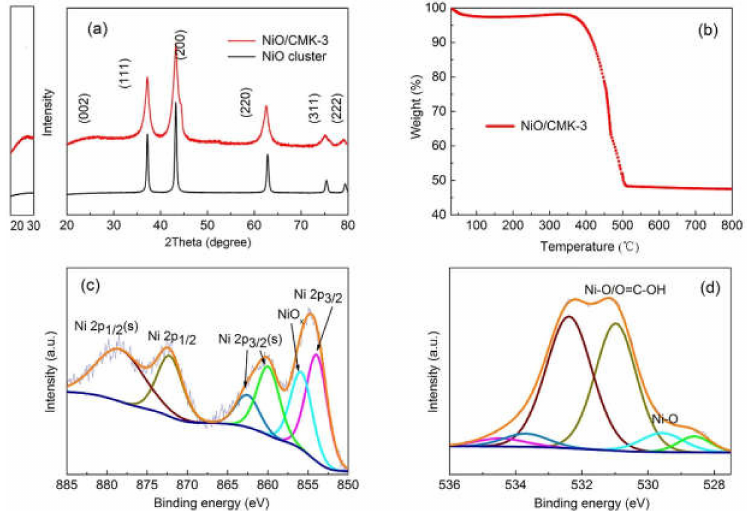
Figure 2. ( a ) XRD of the NiO / CMK-3 composite and NiO cluster; ( b ) Thermal gravimetric analysis (TGA) curve of NiO / CMK-3 composite; ( c ) Ni 2p XPS spectrum of NiO / CMK-3 composite, wine line: Ni 2 + (Ni2p 1 / 2 s), dark yellow line: Ni 2 + (Ni2p 1 / 2 ), dark cyan line: Ni 2 + (Ni2p 3 / 2 s), green line: Ni 2 + (Ni2p 3 / 2 s), cyan line: Ni 3 + , magenta line: Ni 2 + (Ni2p 3 / 2 ); ( d ) O1s XPS spectrum of NiO / CMK-3 composite, wine line: O 2 + (NiO x ), dark yellow line: O 2 + (NiO, C = O), dark cyan line: O 2 + (H 2 O), green line: O 2 + (NiO), cyan line: O 2 +